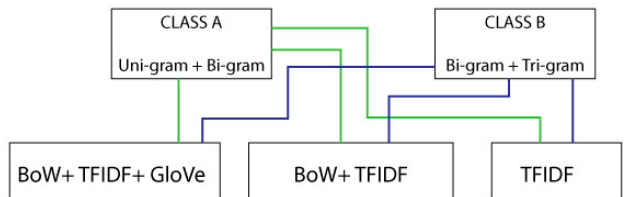
Figure 11. Implementation Framework of Hybrid Features.